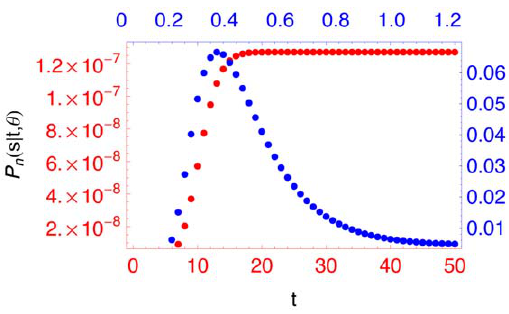
Figure 3. The likelihood function of t for two values of h . For a sample of 15 DNA sequences with 25 polymorphic sites at a locus, the likelihood function of the elapsed time ( t ) is plotted for the values of h ~ 0 : 96 and h ~ 19 : 2 in red and blue,